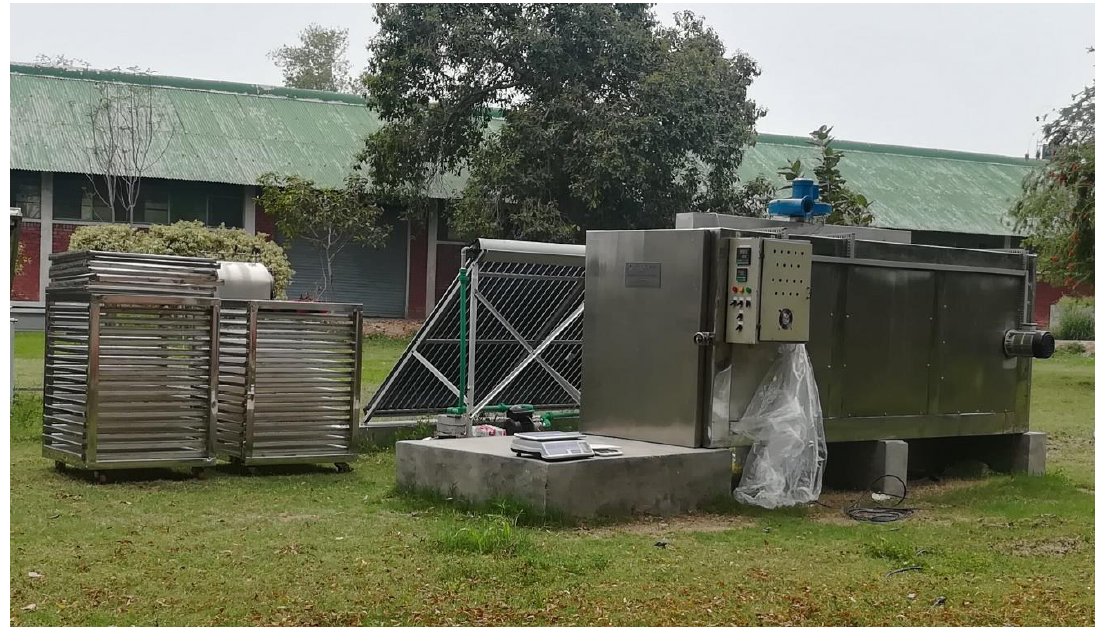
Figure 2. Real time experimental setup of solar hybrid food dehydrator.